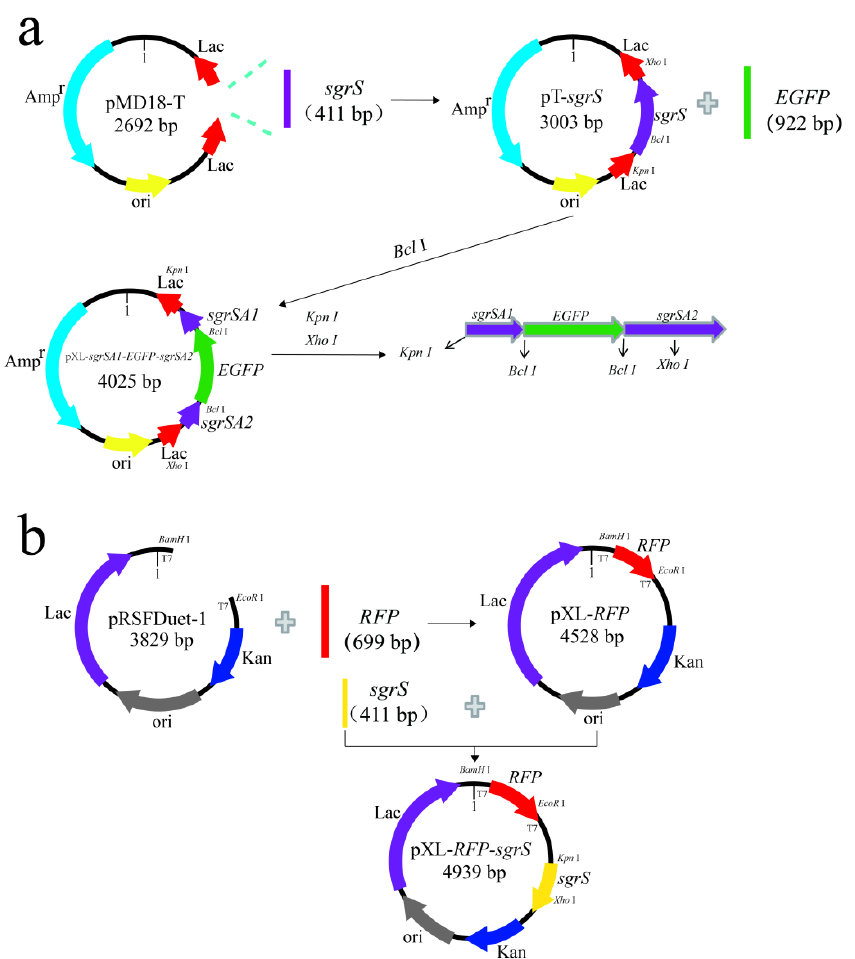
Figure 2. Diagram of the process of constructing a recombinant vector. ( a ) shows the whole strategy of homologus recombination fragment sgrSA1 - EGFP - sgrSA2 . ( b ) shows the construction process of recombinant overexpression vector pXL- RFP - sgrS containing target gene sgrS .